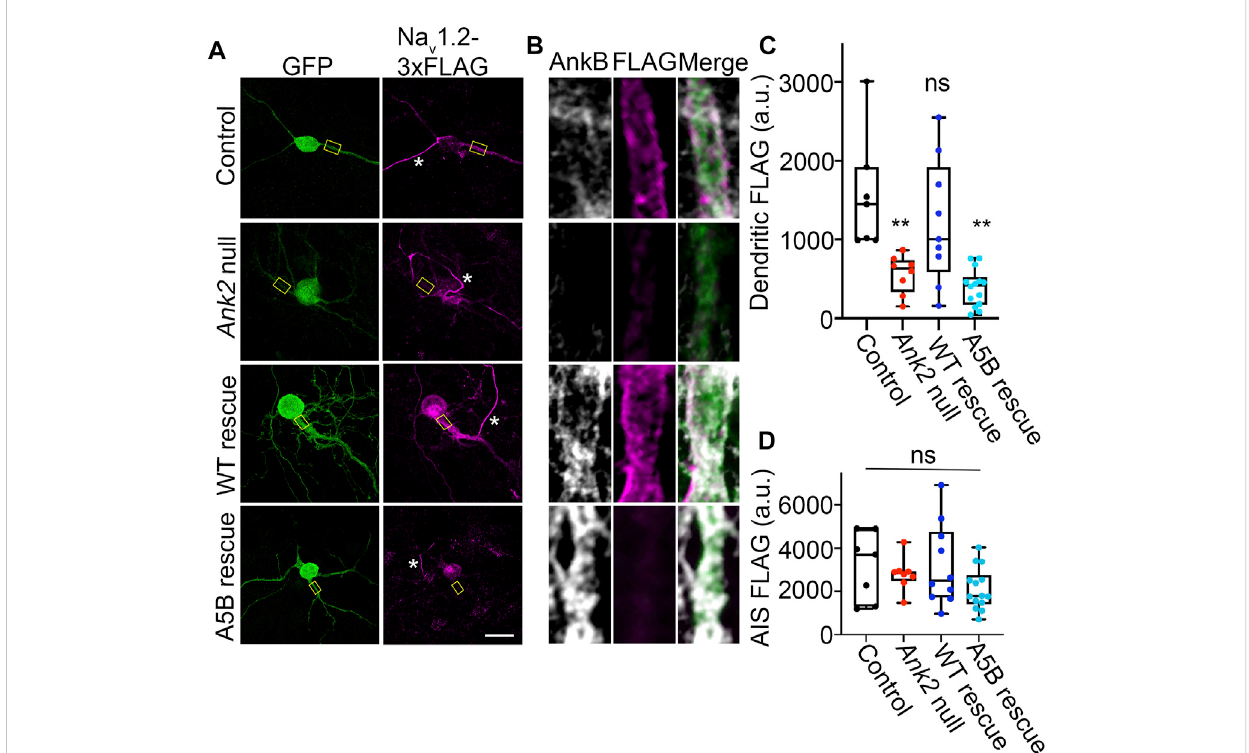
FIGURE 6 Loss of ankyrin-B palmitoylation prevents Na V 1.2 from localizing properly at dendritic membranes of cultured neocortical neurons. (A) . Representative collapsed Z -stacks of DIV21 cultured fl oxed Ank2 cortical neurons transfected at DIV2 with Na V 1.2-3x FLAG (Control) ( Top ), Cre-2A-BFP and Na V 1.2-3x FLAG to generate total ankyrin-B-null neurons ( Second from top ), or Cre-2A-BFP, Na V 1.2-3x FLAG, and indicated GFP rescue constructs ( Bottom ). Stars denote axon initial segment. Scale bars 20 μ m. Neurons stained with anti-GFP shown in green, anti-FLAG shown in magenta, and anti-ankyrin-Bshowningreyscale. (B) .Zoomed-insingle-stackimagesofselecteddendriticcompartmentfrom A (denotedbyyellowsquare).Anti-FLAG is shown in magenta, and anti-ankyrin-B is shown in far red. AAAAA-ankyrin-B-cannot rescue the loss of dendritic membrane localization of Na V 1.2-3x FLAG induced by Cre-mediated deletion of ankyrin-B, compared to WT ankyrin-B-GFP. (C) . Quanti fi cation of mean fl uorescence intensity of dendritic Na V 1.2-3x FLAG from A,B . ** p < 0.01 relativeto Control;one-wayANOVA with Tukey ’ s post-hoc test, N = 7 – 14 for each group across three independent replicates. (D) . Quanti fi cation of mean fl uorescence intensity of AIS Na V 1.2-3x FLAG from A,B . There is no change in AIS Na V 1.2-3x FLAG localization